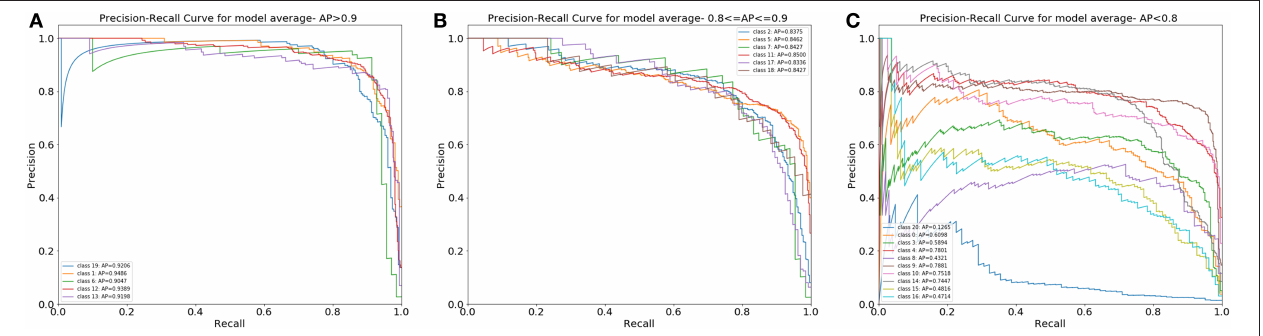
FIGURE 6 | The PR curves of the differential count of 20 types of cells. (A) Cell classes with an AP over 0.9. (B) Cell classes with an AP from 0.8 to 0.9. (C) Cell classes with an AP under 0.8.